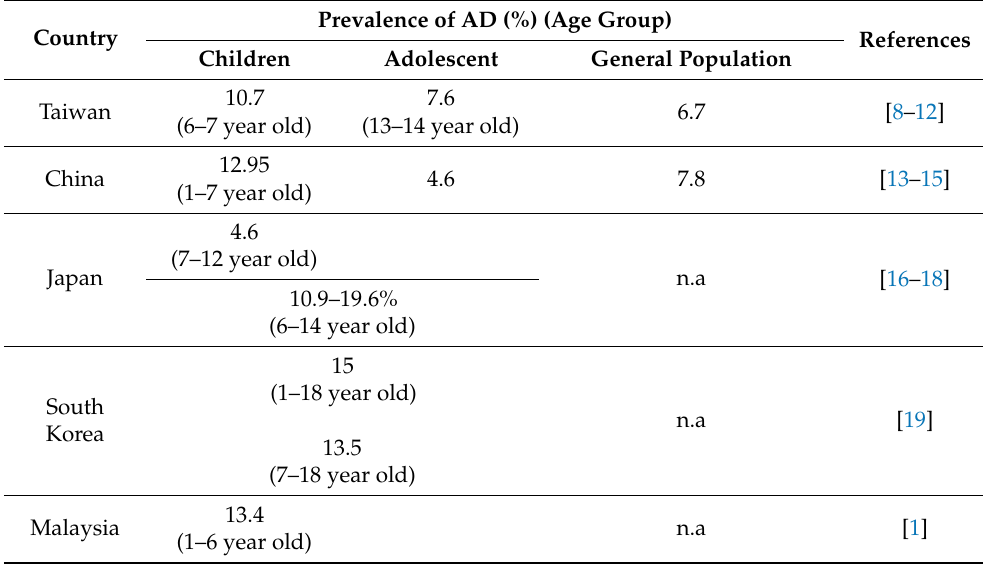
Table 1. Prevalence of atopic dermatitis in Asian countries. Prevalence of AD (%) (Age Country